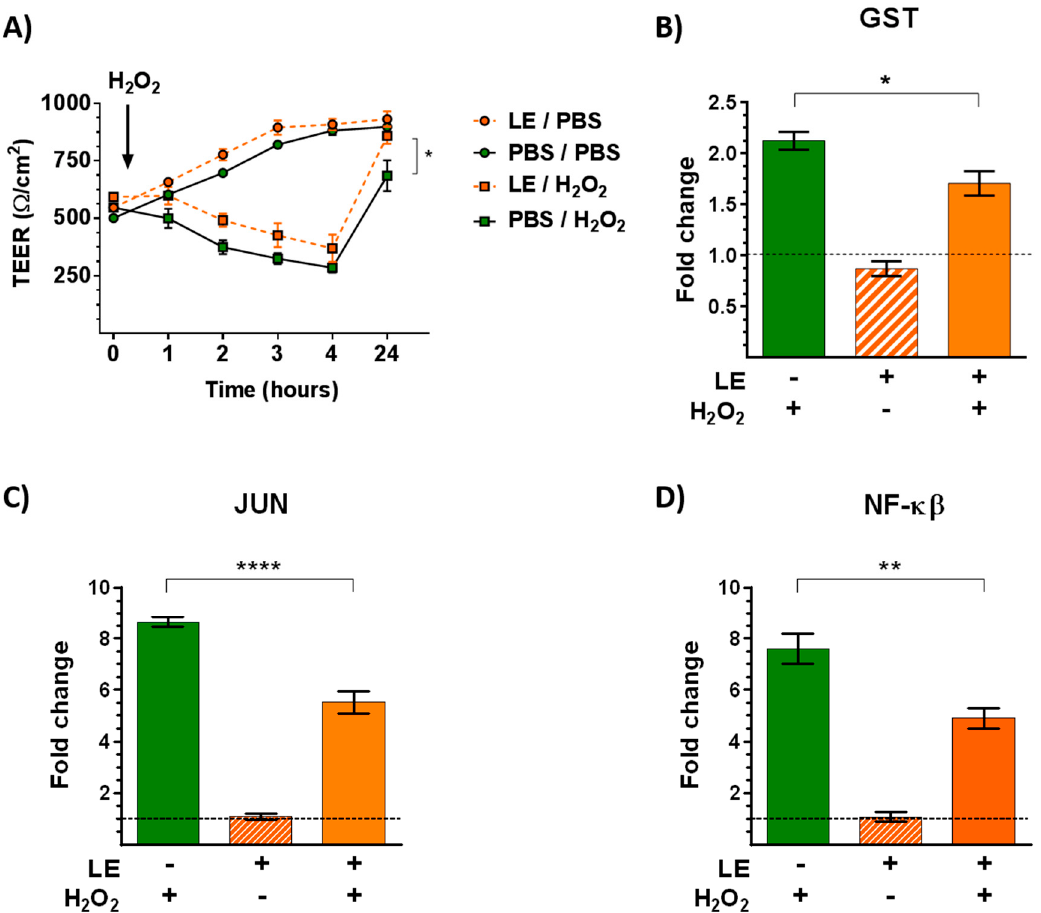
Figure 3. ( A ) E ff ect of leek extract on the response of epithelial cells to oxidative stress. On day 7, ALI-cultured Calu-3 cells were grown in the presence or absence of leek extract (LE, 5 µ g / mL) for 48 h and then exposed to 1 mM H 2 O 2 . The time course of transepithelial electrical resistance (TEER) was measured. PBS, control cells. * p < 0.05 mRNA levels of GST ( B ), c-Jun ( C ) and NF κ B ( D ) in ALI-cultured Calu-3 cells exposed to 1mM H 2 O 2 for 48 h, after treatment with leek extract (5 µ g / mL, LE) compared to control cells (PBS). Relative mRNA levels were determined by RT–PCR and expressed as fold increase of control values after normalization using GADPH as the housekeeping gene. Data are mean ± SEM of three di ff erent experiments. * p < 0.05, ** p < 0.01, **** p < 0.0001.